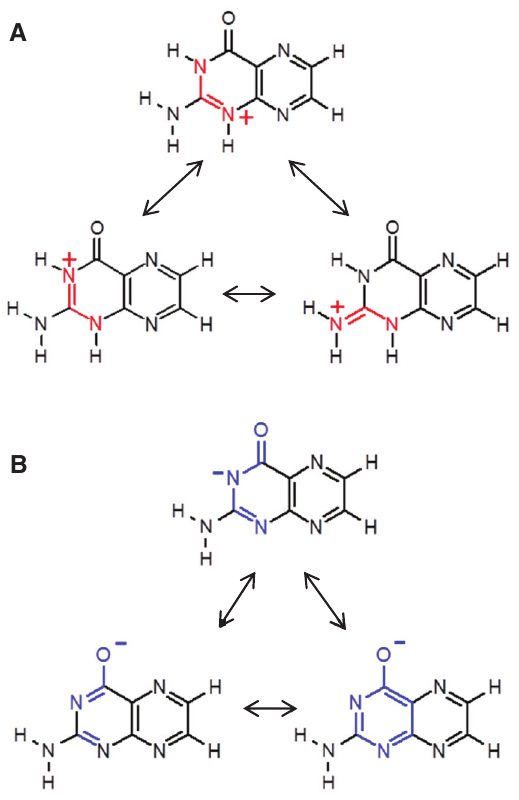
Figure 5 “Traditional” interpretation of the results shown in Figures 3 and 4 in terms of mesomeric resonance structures for the pterin cation (top) and anion